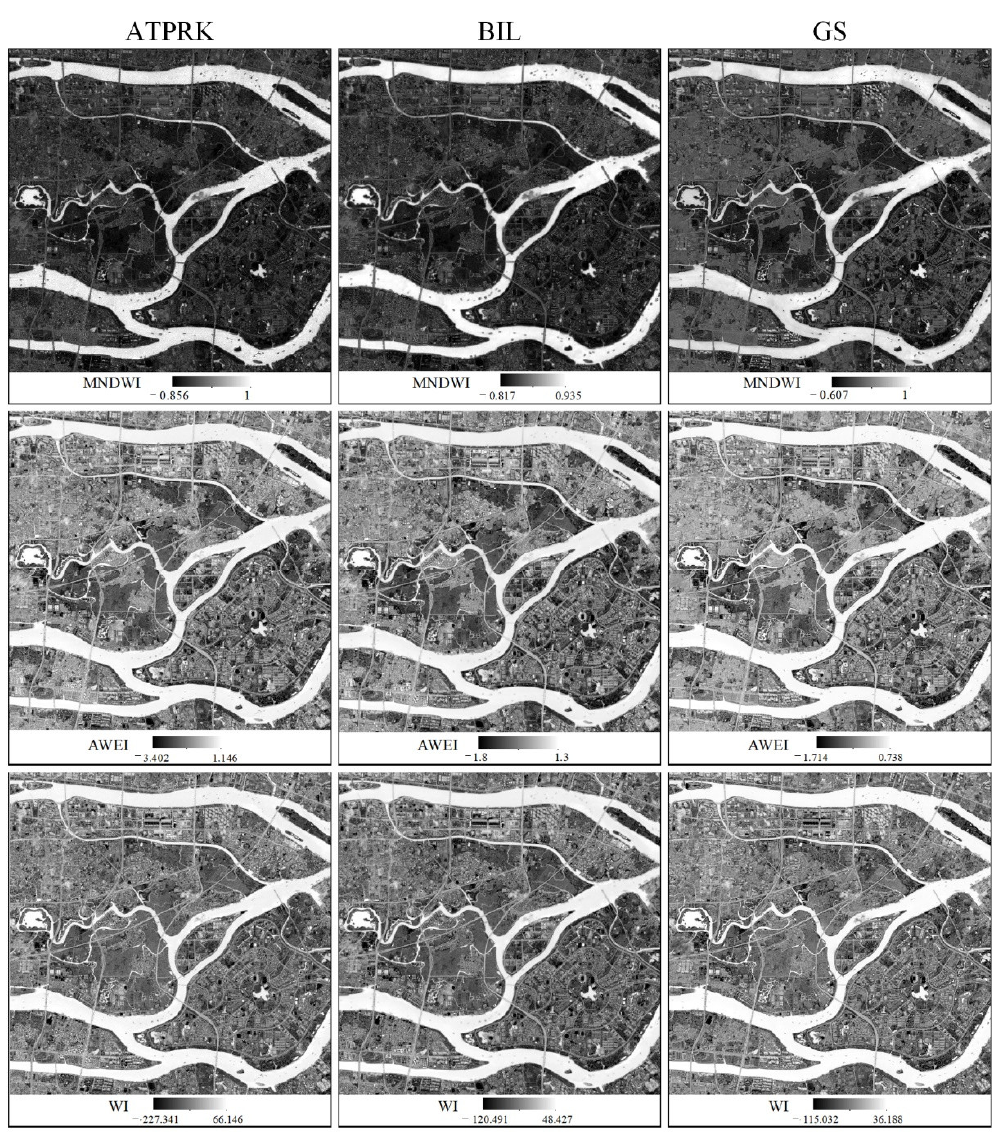
Figure 4. Results of the MNDWI, AWEI sh , and WI 2015 water indices using the ATPRK, BIL, and GS downscaling methods.